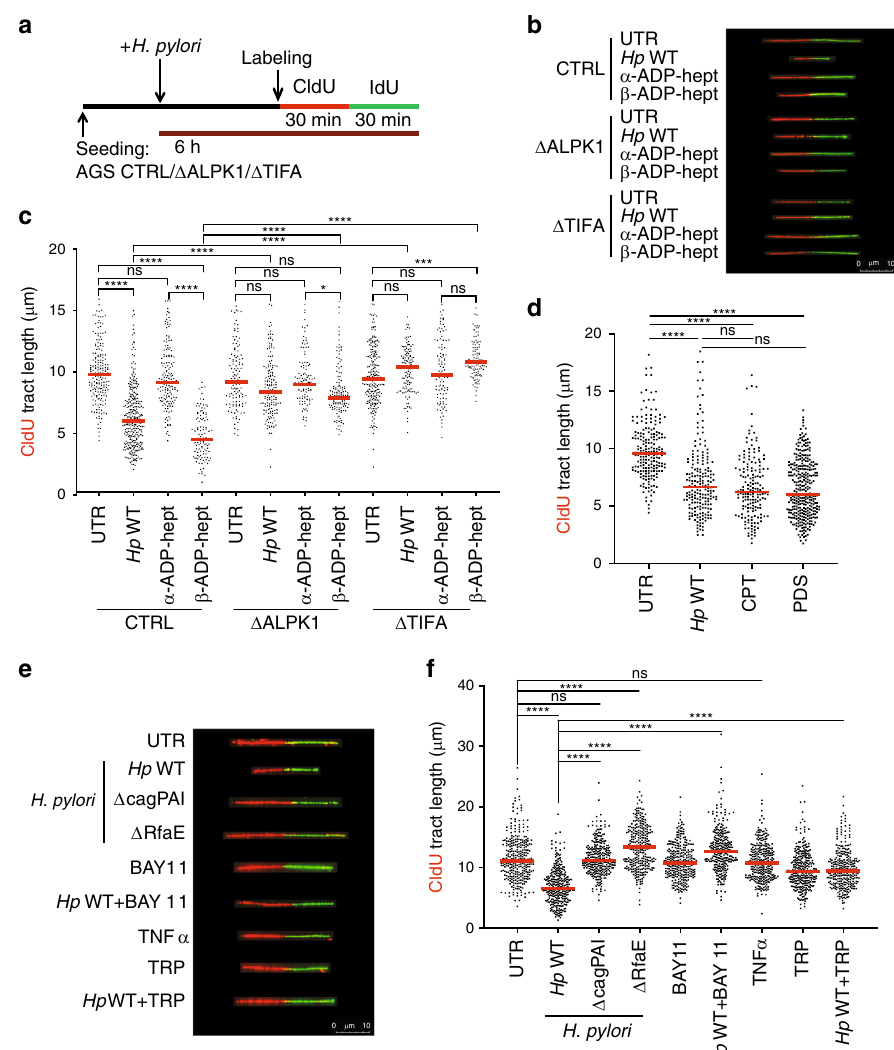
Fig. 4 H. pylori induces DNA replication stress in host cells. a Schematic representation of the protocol used for the quanti fi cation of the length of newly synthesized DNA tracts ( fi bers). b , c Wild-type (CTRL), ALPK1-de fi cient ( Δ ALPK1), and TIFA-de fi cient ( Δ TIFA) AGS cells were either infected for 6 h with H. pylori strain P12 (MOI of 50) or treated with 0.5 μ M α - or β -ADP-heptose and then labeled sequentially with CIdU and IdU as shown in a . Representative DNA fi bers are shown in b and scatter dot plots of CIdU tract length (in μ m) are shown in c for the indicated conditions. At least 106 and up to 318 fi bers were analyzed per condition. Data in c are pooled from two independent experiments. d Wild-type AGS cells were either infected for 6 h with H. pylori strain P12 (MOI of 50) or treated with 100 nM camptothecin (CPT) or 10 μ M pyridostatin (PDS) for 6 h and then labeled sequentially with CIdU and IdU as shown in a . At least 200 fi bers were analyzed per condition. Data in d are pooled from two independent experiments. e , f AGS cells were infected for 6 h with either the wild-type H. pylori strain P12 or its isogenic RfaE and Cag-PAI mutants (MOI of 50) and/or treated with the NF- κ B inhibitor BAY 11-7082 (1 μ M), the transcription inhibitor triptolide (100 nM), or TNF- α (10 nM) and labeled sequentially with CIdU and IdU during the last 60 min of infection as shown in a . Representative DNA fi bers are shown in e and scatter dot plots of CIdU tract length (in μ m) are shown in f for the indicated conditions. At least 141 and up to 213 fi bers were analyzed per condition. Data in f are pooled from two independent experiments. Red lines indicate medians throughout. P -values were calculated throughout by one-way ANOVA with Dunn ’ s multiple comparisons correction. ns, not signi fi cant; * p < 0.05, **** p < 0.0001.